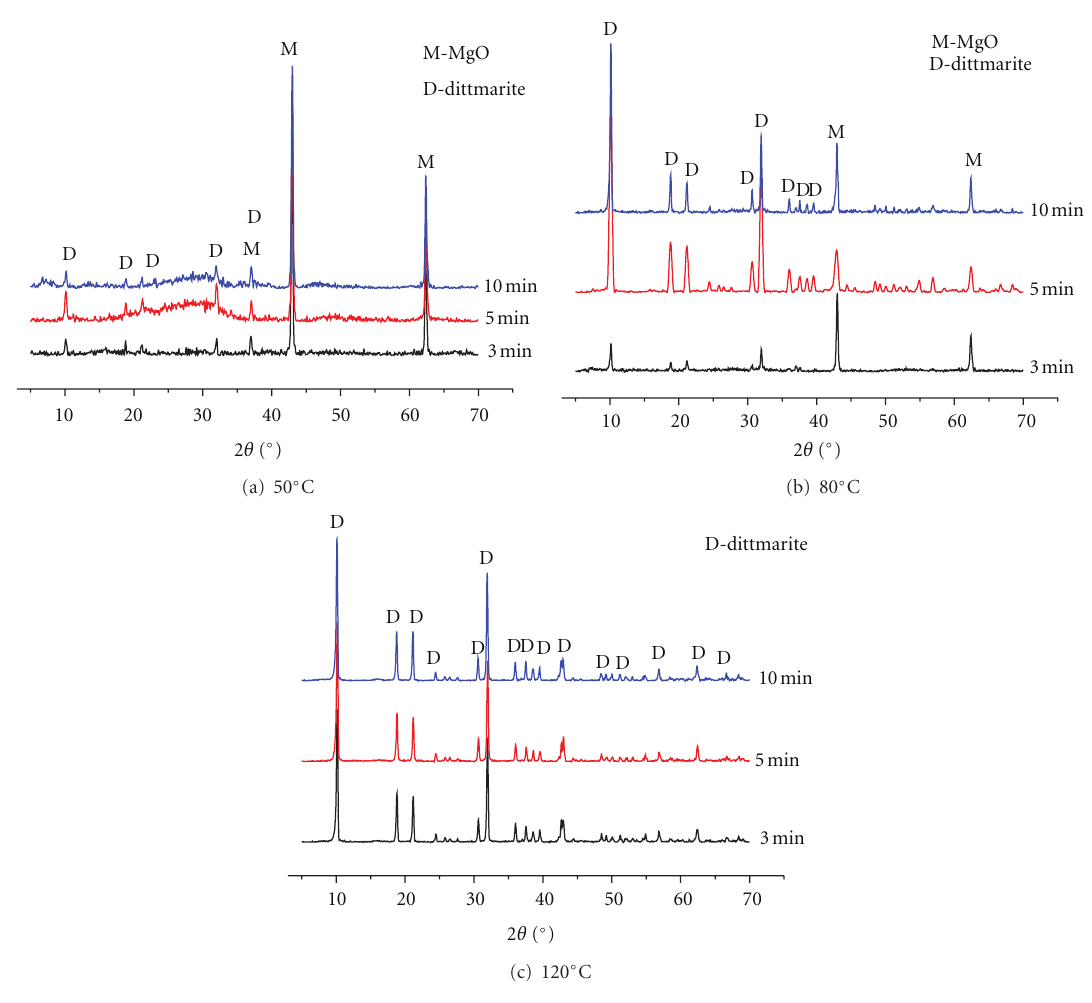
Figure 1: XRD patterns of the samples.